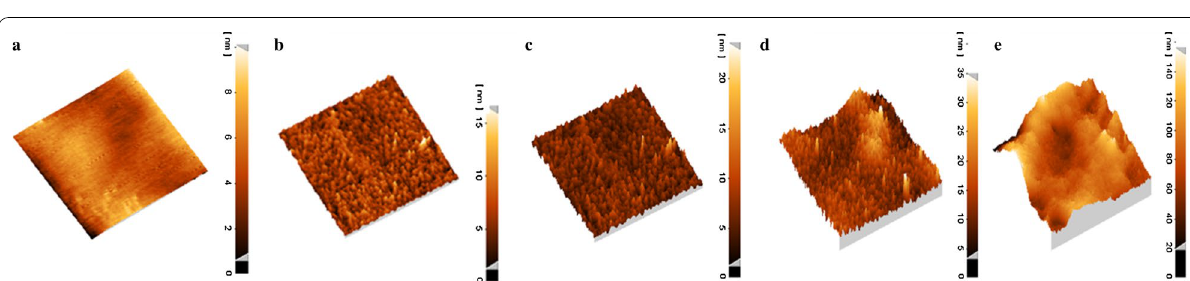
Fig. 4: 3D-dimensional topographic AFM images obtained from the prepared solid-state electrodes ( a : ARLD-1, b : ARLD-2, c : ARLD-3, d : ARLD-4, e :